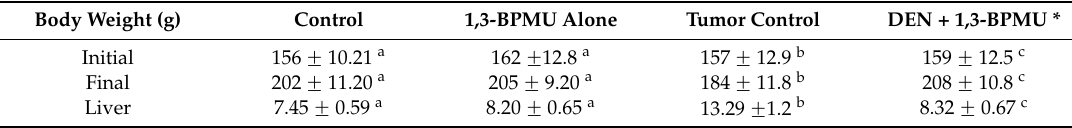
Table 1. Body and liver weight of control and experimental rats.